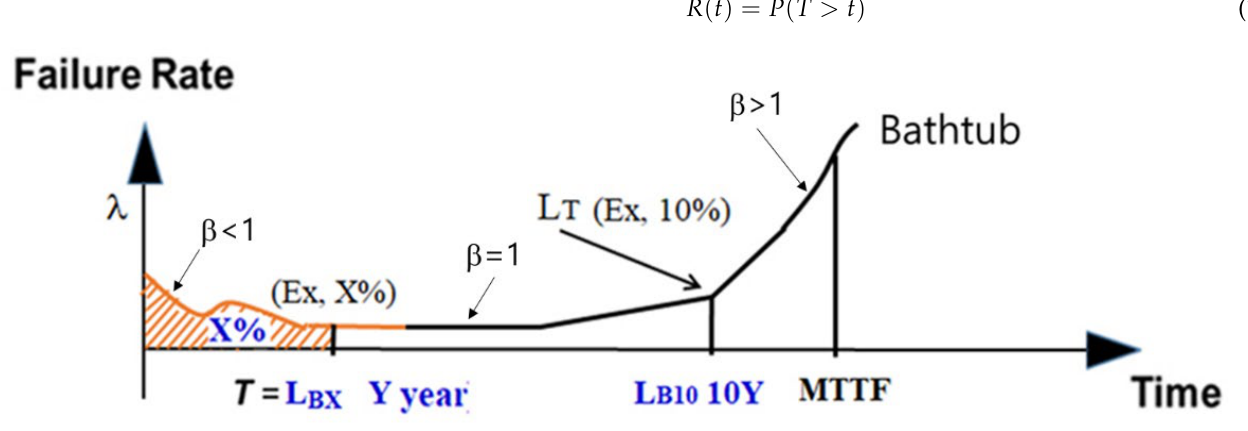
Figure 2. Lifetime index and BX life ( L BX ) on the bathtub .